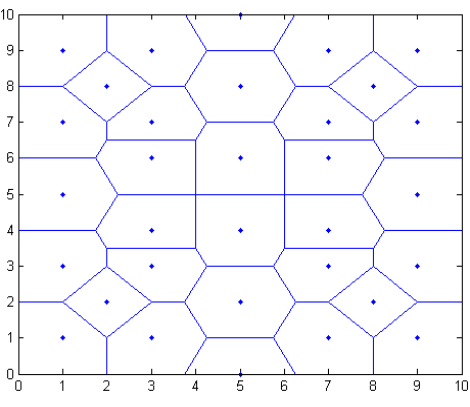
Figure 14. Location division map.